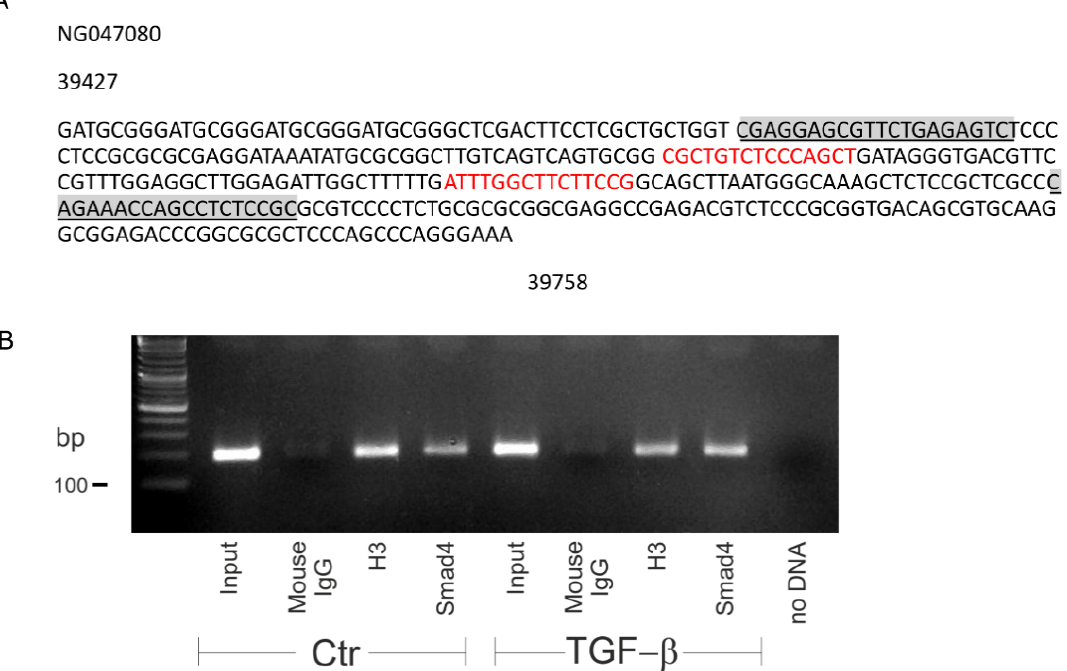
Figure 5. Smad4 specifically binds to the promoter of Slc8a3 . ( A ) Smad4 binding site(s) (red) to the Slc8a3 promoter region. Underlined sequences represent primer sequences used to detect Smad4 binding. ( B ) PCR following the chromatin immunoprecipitation assay of the control and TGF- β -treated (2 ng/mL for 30 min) Lund human mesencephalic (LUHMES) cells demonstrates increased binding of Smad4 to the predicted binding sequence in the promoter region of Slc8a3 . Predicted PCR product size 193 bp. Histone 3 (H3) and mouse IgG represent the positive and negative control, respectively. The figure is a representative of n = 2.